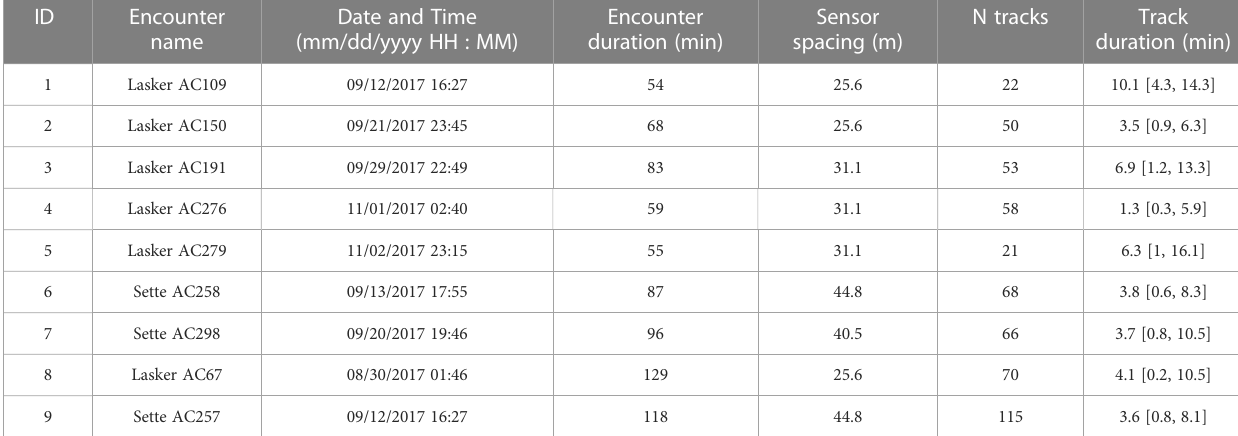
DateandtimeindicatestartoftheencounterreportedinGMT.EncounterdurationisthedurationoftheanalysedencounterandcorrespondstoPhaseIofthesurveyprotocol(Yanoetal.,2018). Track duration is reported as a median per encounter with 25th and 75th percentiles in the brackets.